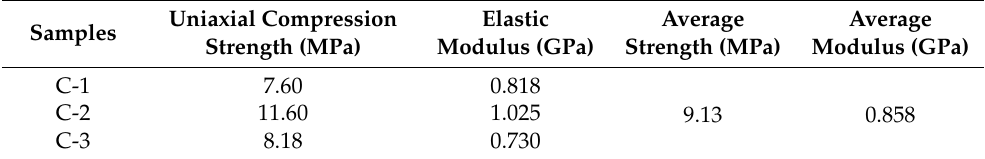
Table 2. Strength and deformation characteristics of coal samples.